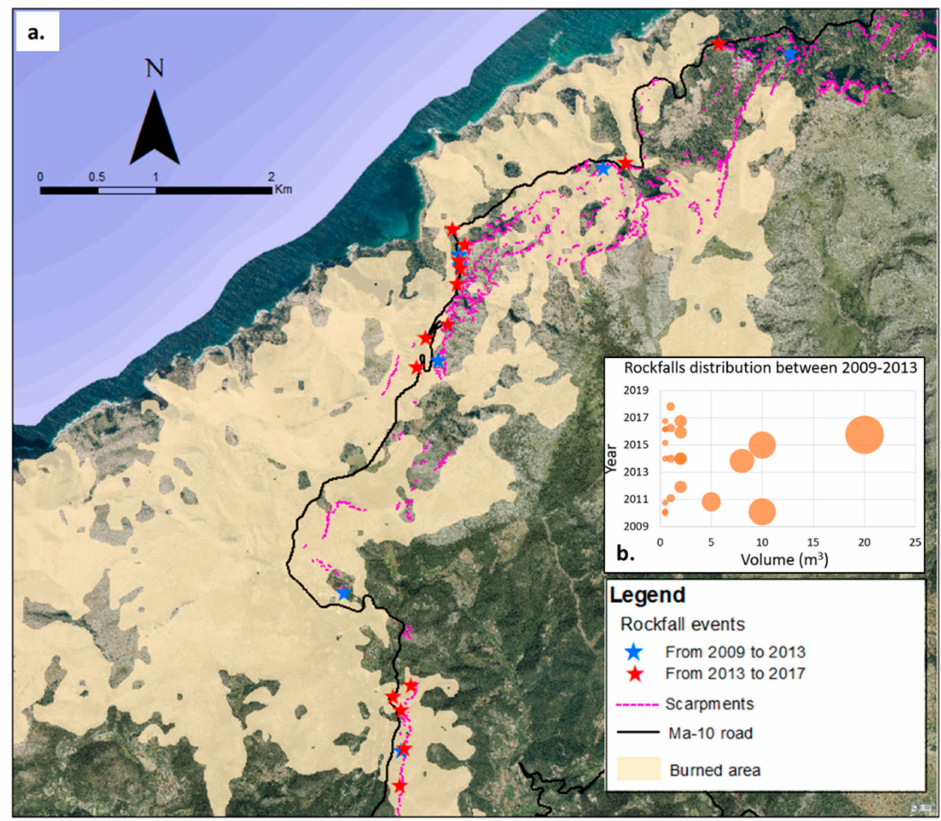
Figure 12. ( a ) Rockfalls occurred before and after the wildfire in the Tramuntana range (Mallorca) in 2013. We considered the rockfalls in the Ma-10 road reported by the road maintenance service of Mallorca. ( b ) Rockfall distribution according to the volume of the boulders and considering the year of